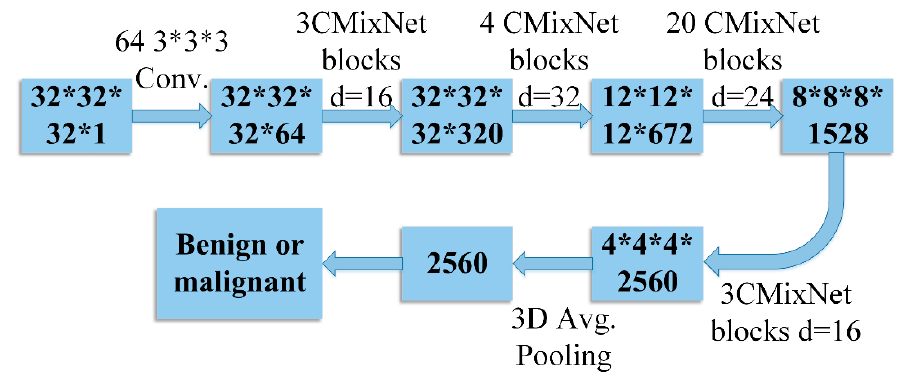
Figure 8. Nodule classification using CMixNet and GBM. The numbers in the boxes represent the sizes of the feature maps in the sequence #slices, #rows, #cols, and #maps. The numbers outside the boxes are in sequence #filters, #slices, #rows, and #cols.